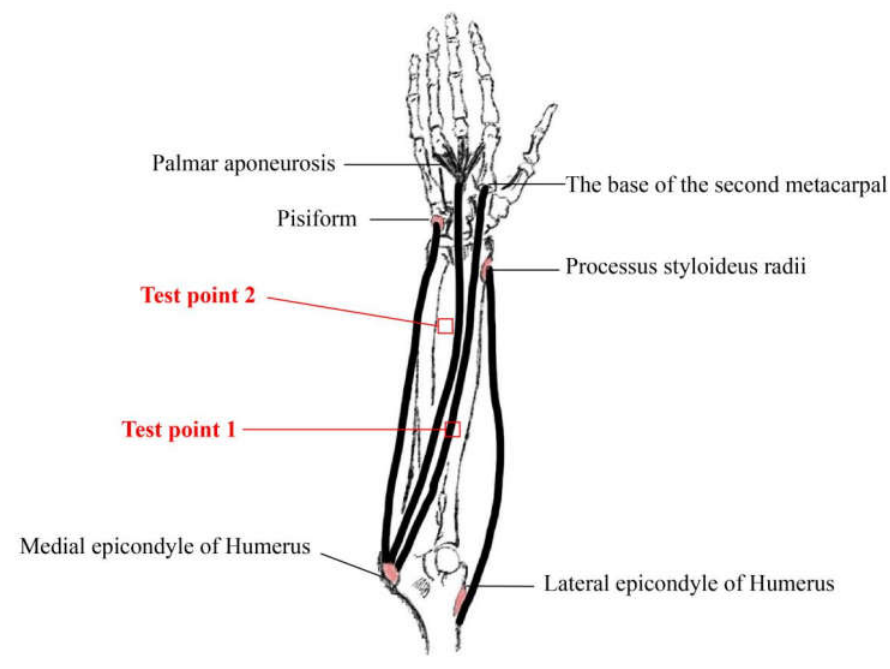
Figure 1. Location of skin–blood microcirculation test points. Establishment of fabric sample test scheme: Determination of test scheme of fabric- perforated, width, and covered time.